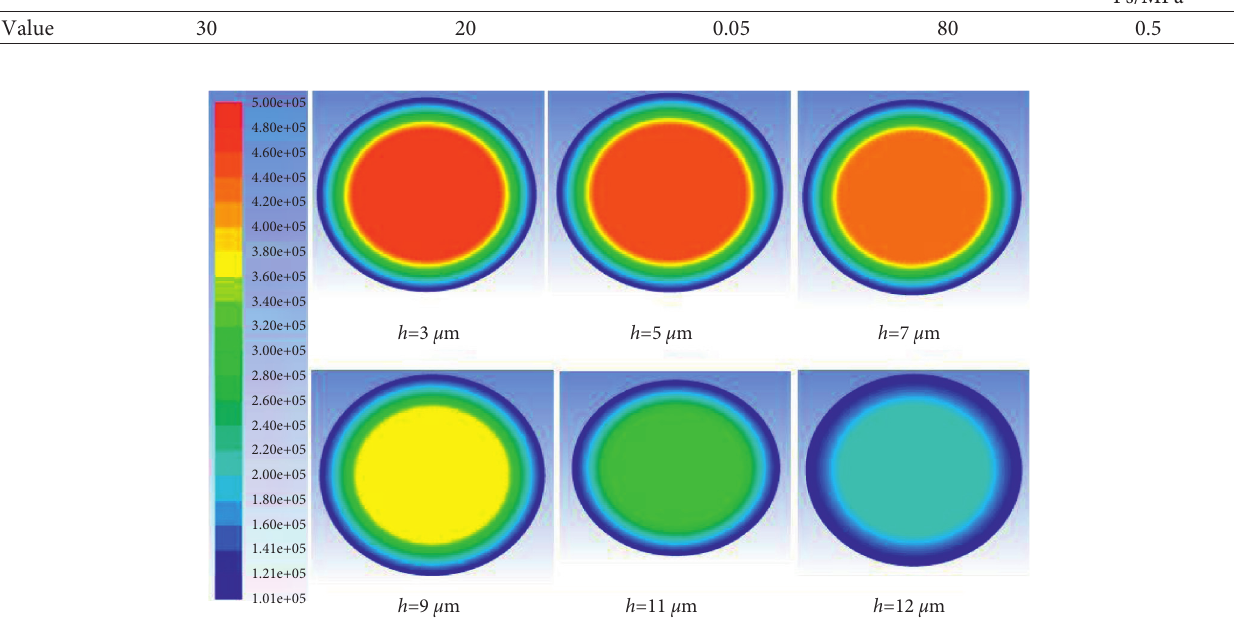
Figure 4: Pressure distribution of annular array microporous throttling aerostatic